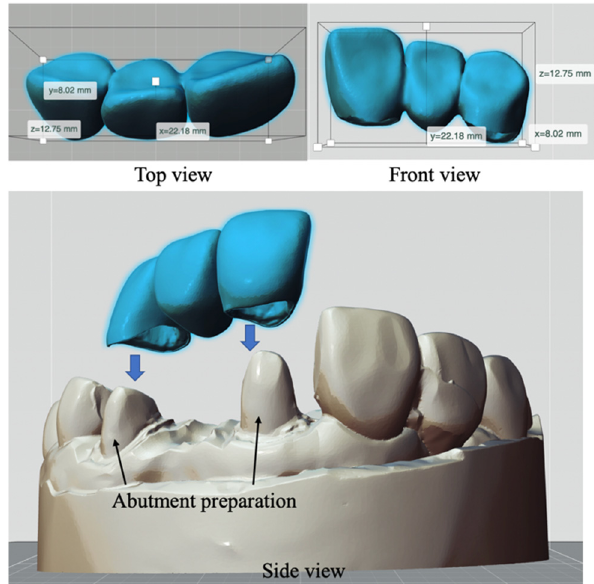
Figure 5. The proposed benchmark: top and front views ( top ) and assembled view for a three-unit dental crown and a dental stone model ( bottom ).